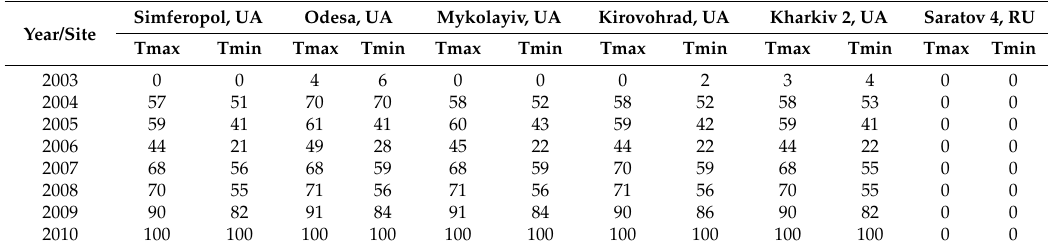
Table 1. Percentage of days with meteorological station data missing during the growing season.